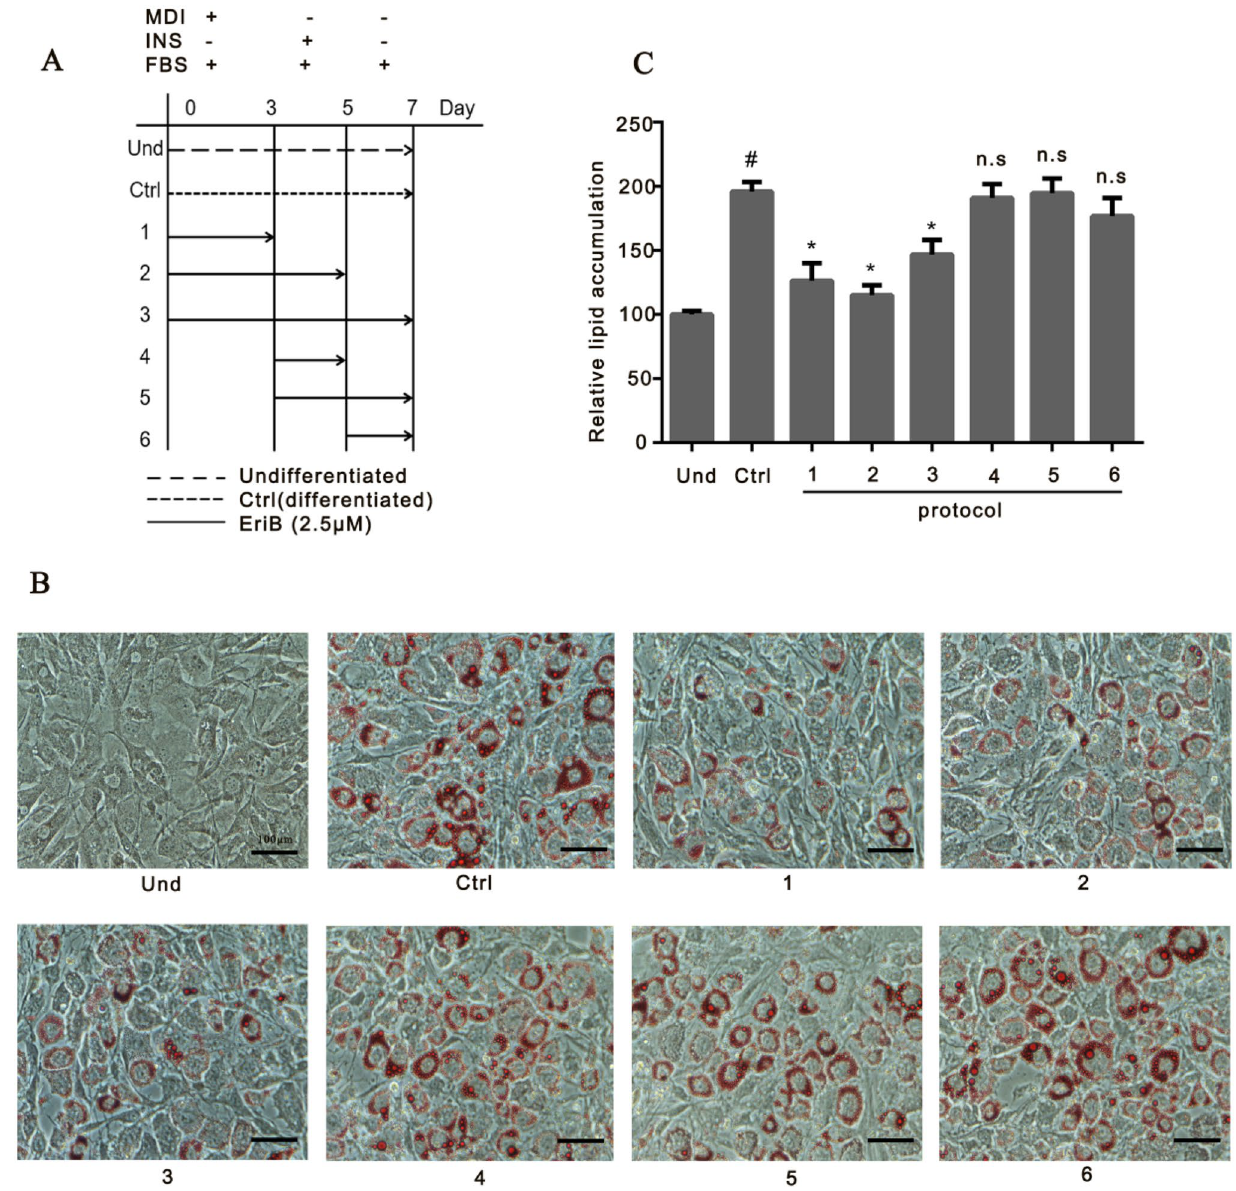
Fig. 3 Eriocalyxin B inhibited adipogenesis at the early stages of adipocyte differentiation. Cells were induced for differentia- tion with DMEM supplemented with 10% FBS, IBMX, DEX and insulin (described as MDI). On day 3, the medium was changed to medium containing 10% FBS and insulin for 2 days (called as INS). On day 5, insulin was removed from 10% FBS-DMEM for another 2 days (described as FBS). The cells were fully differentiated into mature adipocytes on day 7. Cells treated with of compound at dif-